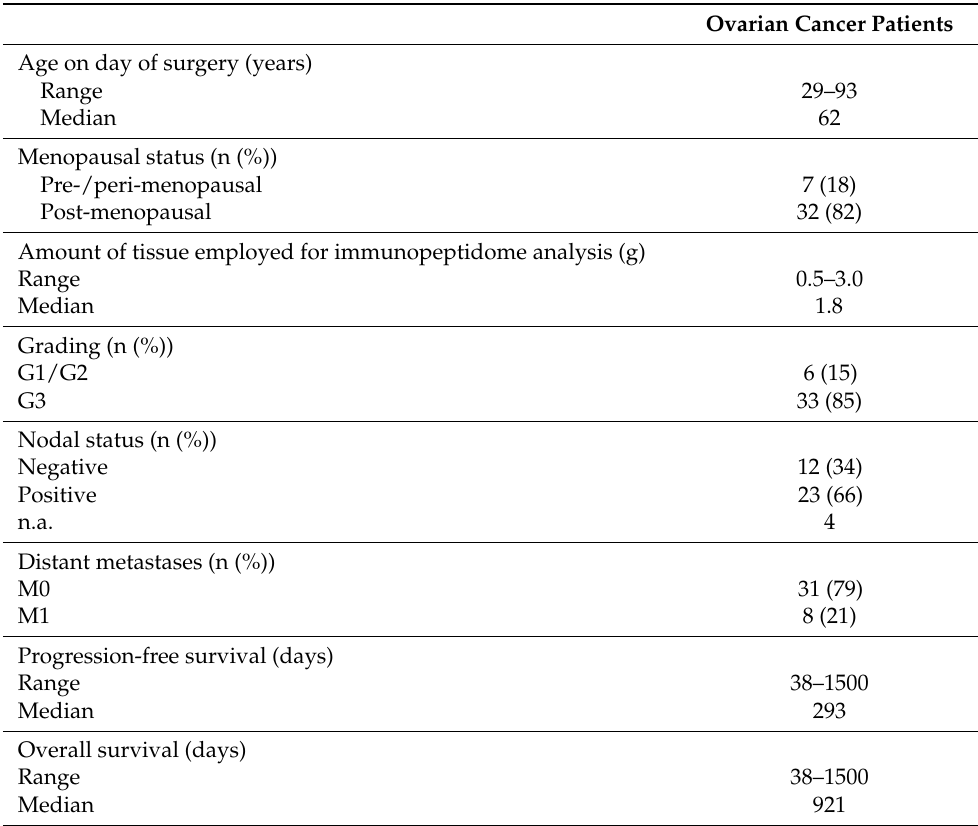
Table 1. Characteristics of patient